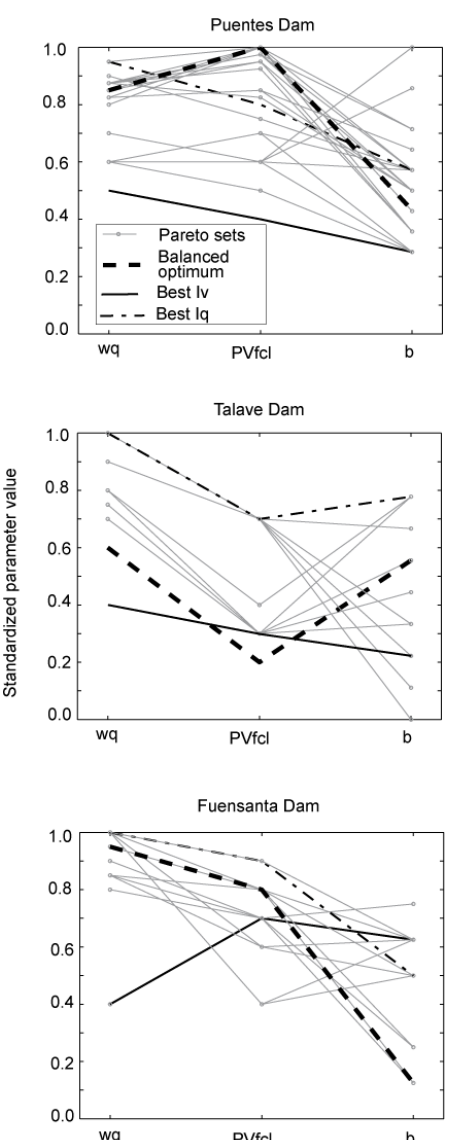
Fig. 11. Standardised range of the parameter values corresponding Figure 11 . Standardised range of the parameter values corresponding to the Pareto solutions. 812 to the Pareto solutions. The balanced optimum solution is shown by The balanced optimum solution is shown by a thick-dashed line 813 a thick-dashed